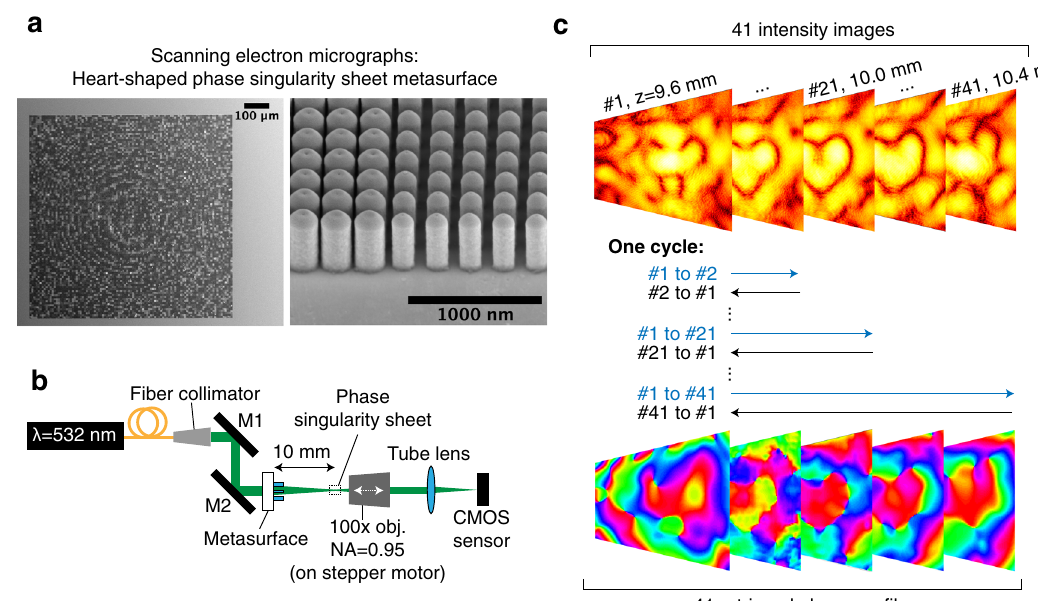
Fig. 4 Fabrication and characterization of the heart-shaped phase-singularity sheet. a Left, scanning electron micrograph of the fabricated metasurface. This metasurface comprises 101 × 101 superpixels with a pitch of 8 μ m. Each superpixel comprises a uniform 32 × 32 array of cylindrical nanopillars with a pitch of 0.25 μ m. a Right, high-magni fi cation SEM of the interface between two superpixels. b Experimental setup for the optical characterization of the heart-shaped phase singularity. The ×100 objective (numerical aperture (NA) = 0.95) is scanned over 41 z -positions (from 9.6 to 10.4 mm) to capture the longitudinal variation of the phase singularity using a complementary metal oxide semiconductor (CMOS) camera sensor. c Iterative single-beam multiple- intensity reconstruction phase retrieval algorithm used to estimate the phase pro fi le at each z -position. During one cycle, the forward propagation is performed from the fi rst image (at z = 9.6 mm) to each image and backwards to the fi rst image. This cycle is performed 50 times to yield the 41 phase pro fi les at each z